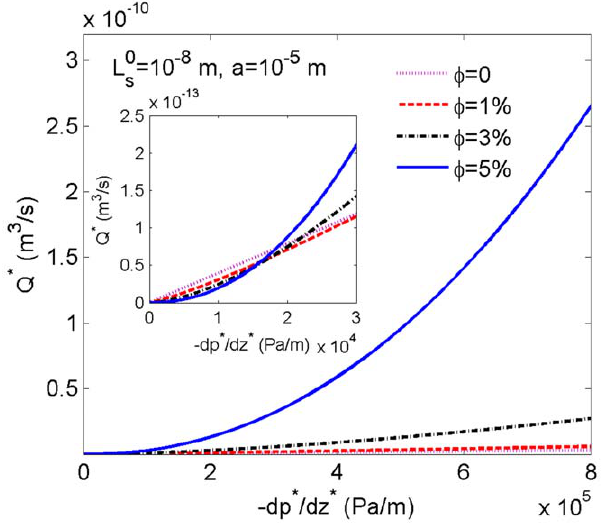
Figure 4. The volumetric flow rate of the nanofluid in a thicker tube. The volumetric flow rates as a function of the pressure gradient are calculated for w ~ 0, 1%, 3% and 5% with radius a ~ 10 { 5 m and slip ~ 10 { 8 m . length L 0 s